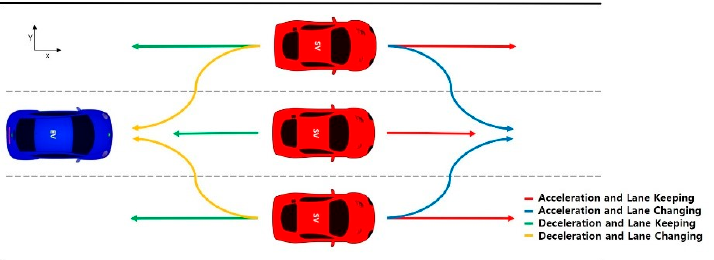
Figure 15. Trajectory definition for data set: acceleration and lane keeping (same/adjacent), acceler- ation and lane changing (left/right).